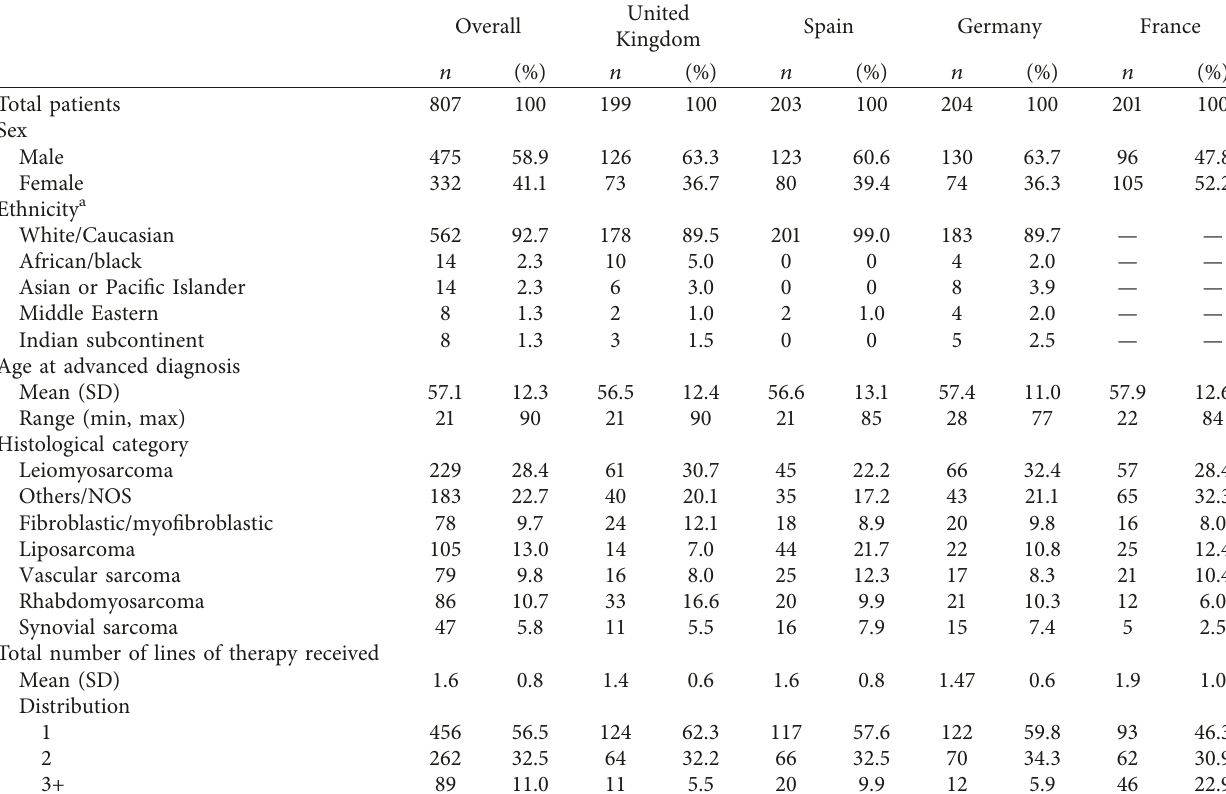
Table 1: Patient and treatment